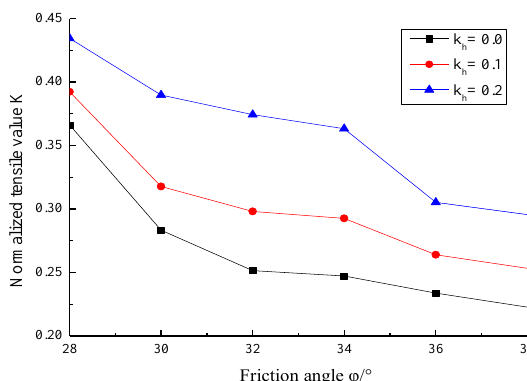
Figure 4. Normalized tensile force of reinforcement under seismic load when k v = 0.